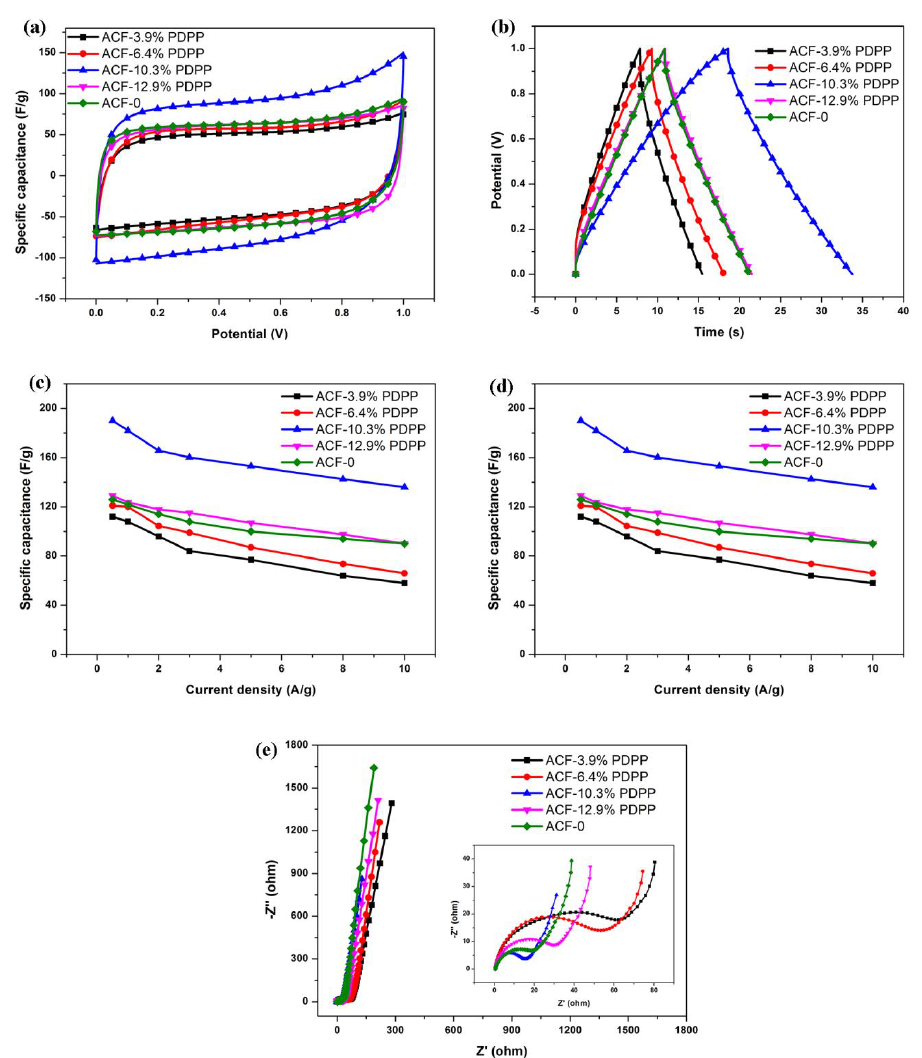
Figure 6. ( a ) CV curves of all samples at a scan rate of 30 mV·s −1 ; ( b ) GCD curves of all samples at current densities of 5 A·g −1 ; ( c ) specific capacitance of each sample at different current densities (0.5 – 10 A·g −1 ); ( d ) Ragone plots as a function of current densities (0.5 – 10 A·g −1 ) of symmetric supercapacitors; and ( e ) Nyquist plots of all samples in the frequency range of 100 kHz and 0.01 Hz. The inset in (e) is the magnified region. Table 5. Surface texture properties of ACFNs prepared from PAA/PDPP fibrous networks with different ratios.